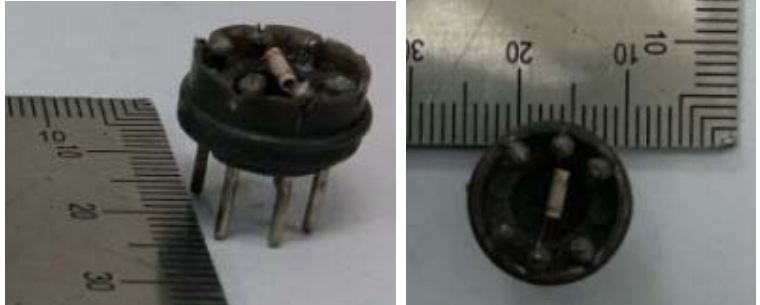
Figure 3. Photograph of a fabricated sensor.